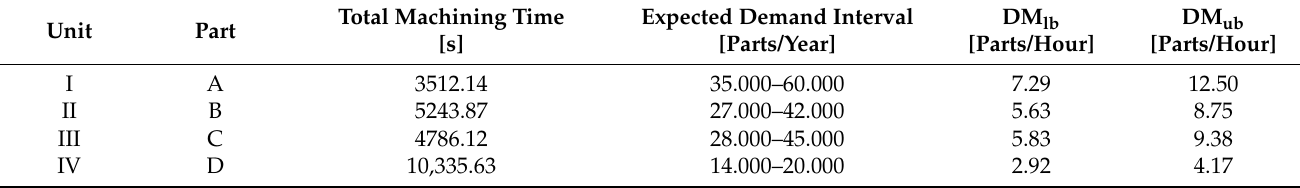
Table 3. Production requirements of the units of the manufacturing